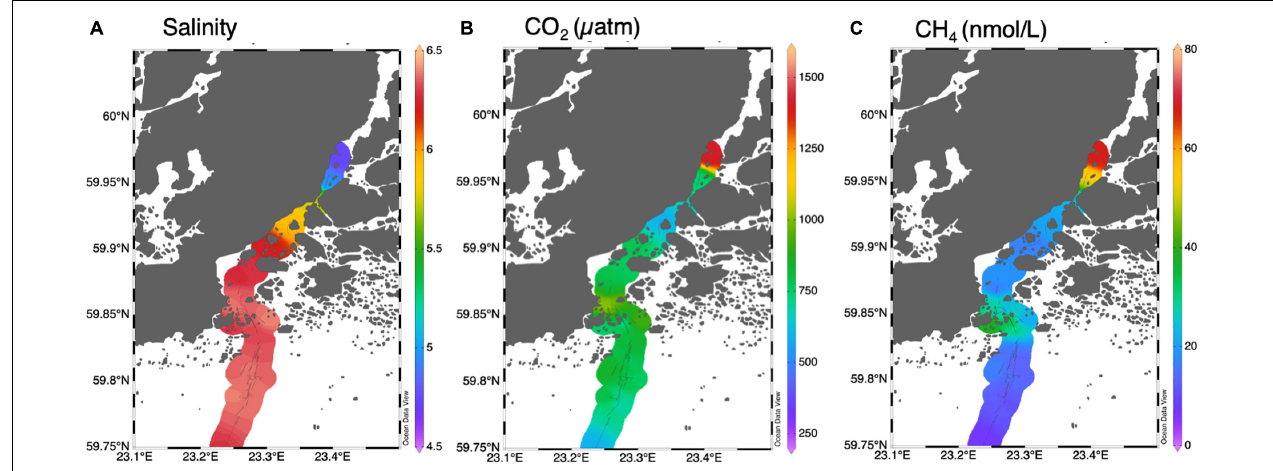
FIGURE 6 | Surface distribution of (A) salinity, (B) pCO 2 ( µ atm), and (C) CH 4 concentrations (nmol/L) within the TZS coastal waters; the black dots indicate daily cruise tracks within the area.